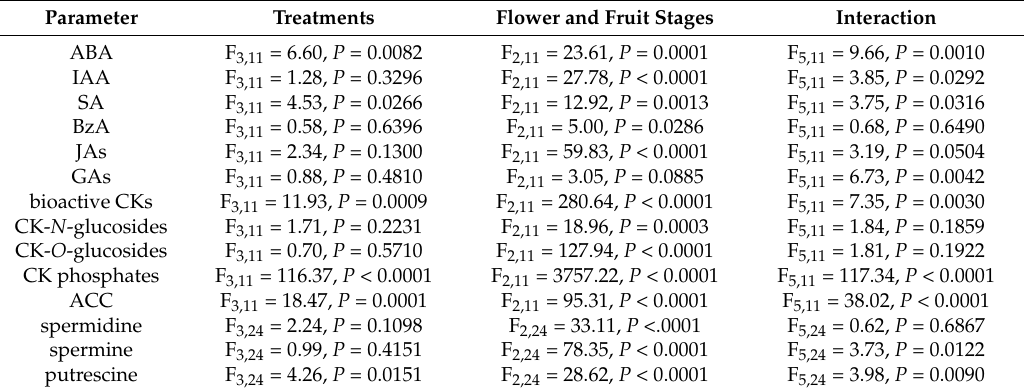
Table 3. Statistical results (ANOVA2) of endogenous phytohormone and PA profiles during early fruit development of fertilized and intrinsic parthenocarpic ‘Conference’ pear fruits. Parameter Treatments Flower and Fruit